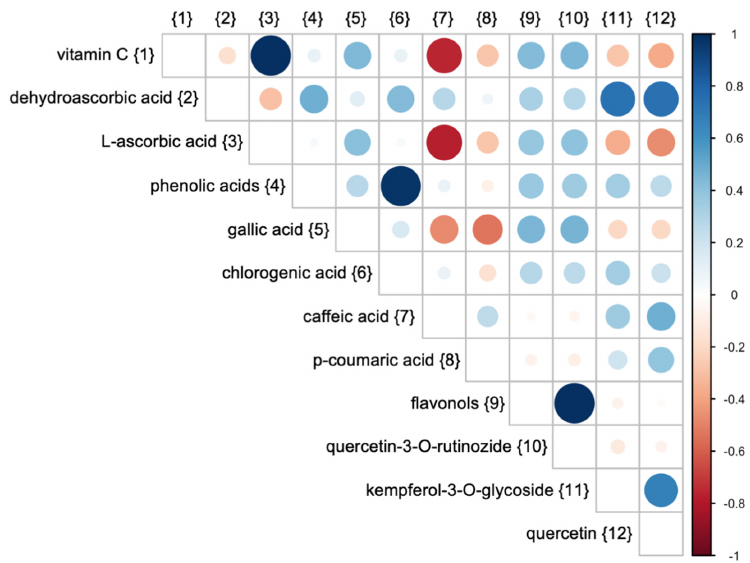
Figure 6. Pearson’s correlation between concentrations of individual phytochemicals (phenolics and vitamin C) identified in apple fruit samples. Colour (blue/red) and its intensity correspond to the direction and the strength of the correlation, while the circle size corresponds to its statistical significance (p-value).